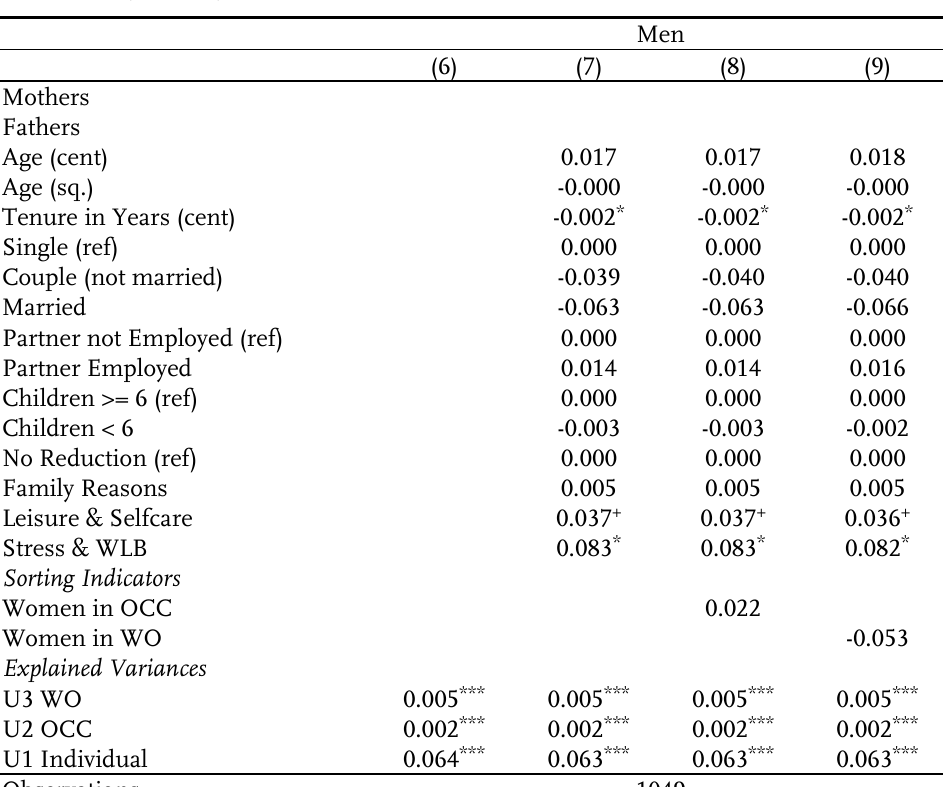
Cross classified multilevel model on reduction of contracted working hours (2 hour